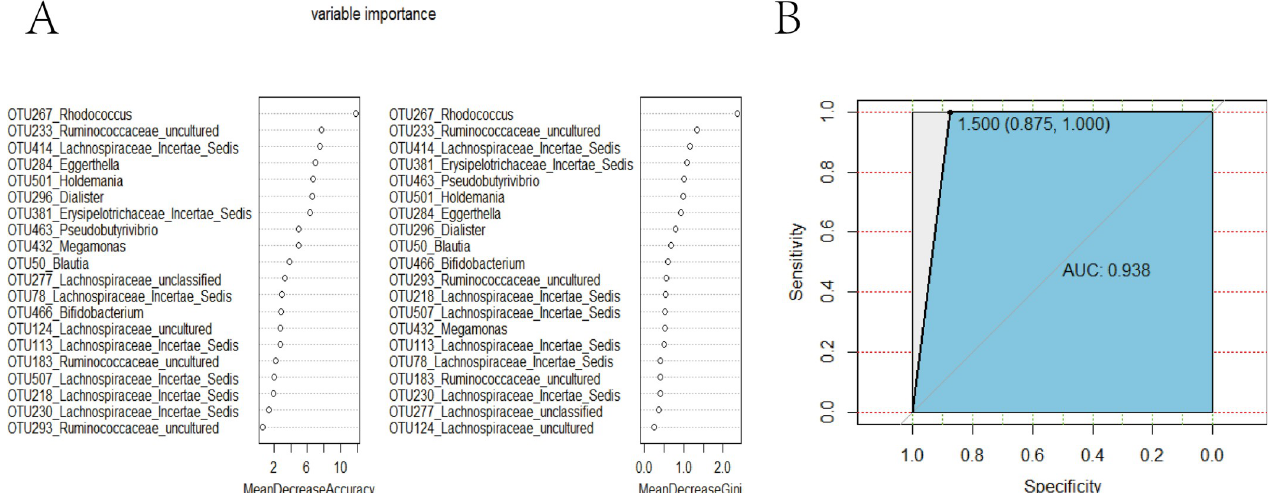
Fig 3. Decision trees to evaluate the fecal microbiota after SCI. (A) An RF predictive model based on genus-level abundance taxa was used to predict the relative importance of each genus based on the mean decreasing accuracy and the Gini coefficient for fecal microbiota. (B) An ROC curve generated using the RF analysis of 20 genera in the fecal microbiota. The ROC curve shows the corresponding optimal threshold. RF, Random Forest; ROC, receiver operating characteristic; AUC, area under the ROC curve.